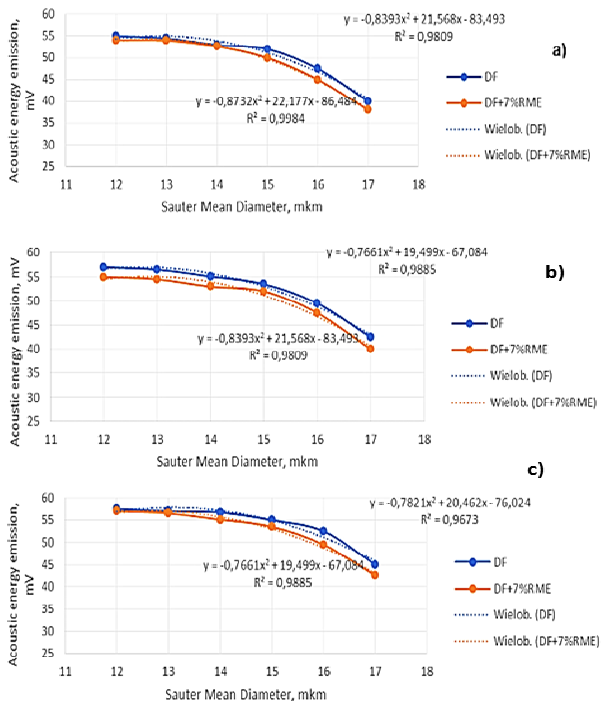
Fig. 10. Relationship between Sauter mean diameter of atomized fuel drop and level of the acoustic emission formed in the atomization process for the start fuel injection pressure: a – 22.0 MPa; b – 24.0 MPa; c – 26.0